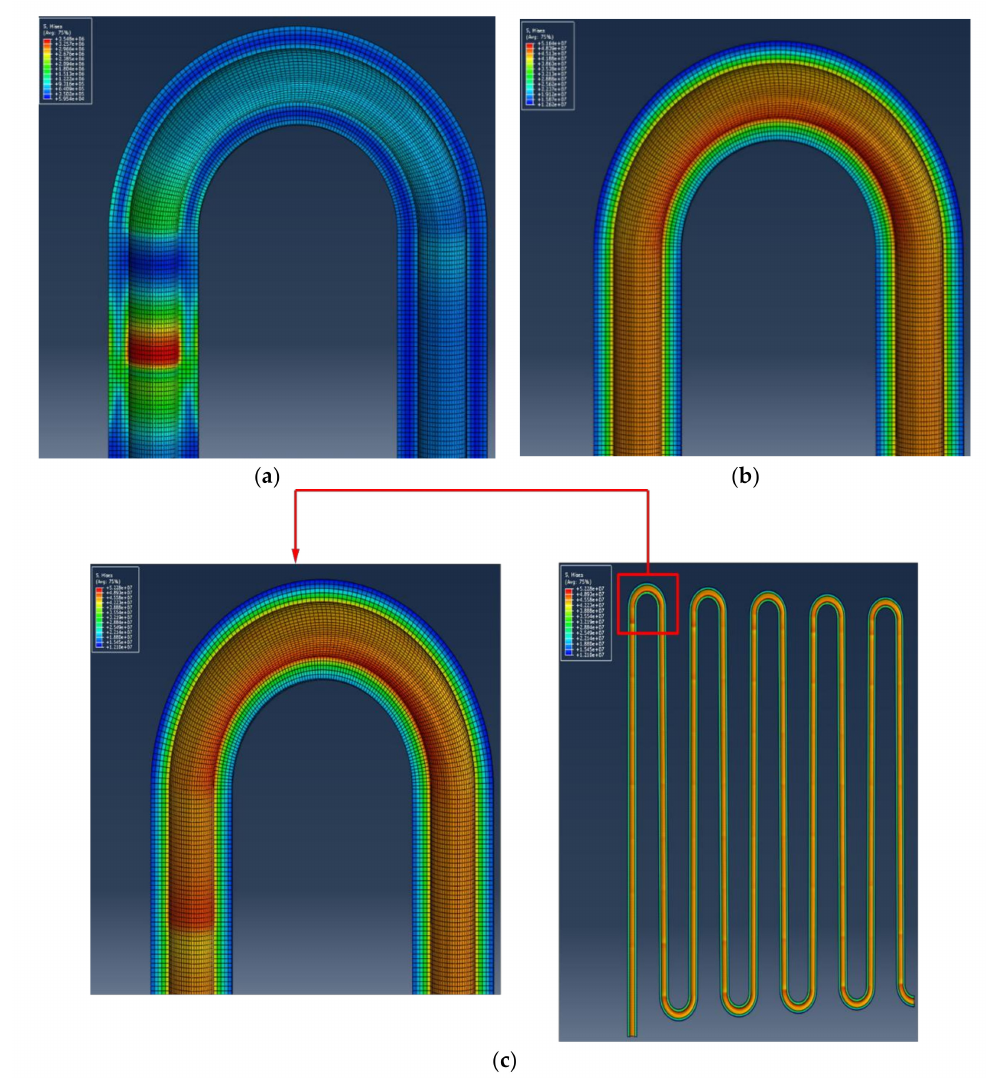
Figure 10. Von-Mises stress distributions: ( a ) thermal loading, ( b ) pressure loading, ( c ) thermal and pressure loading